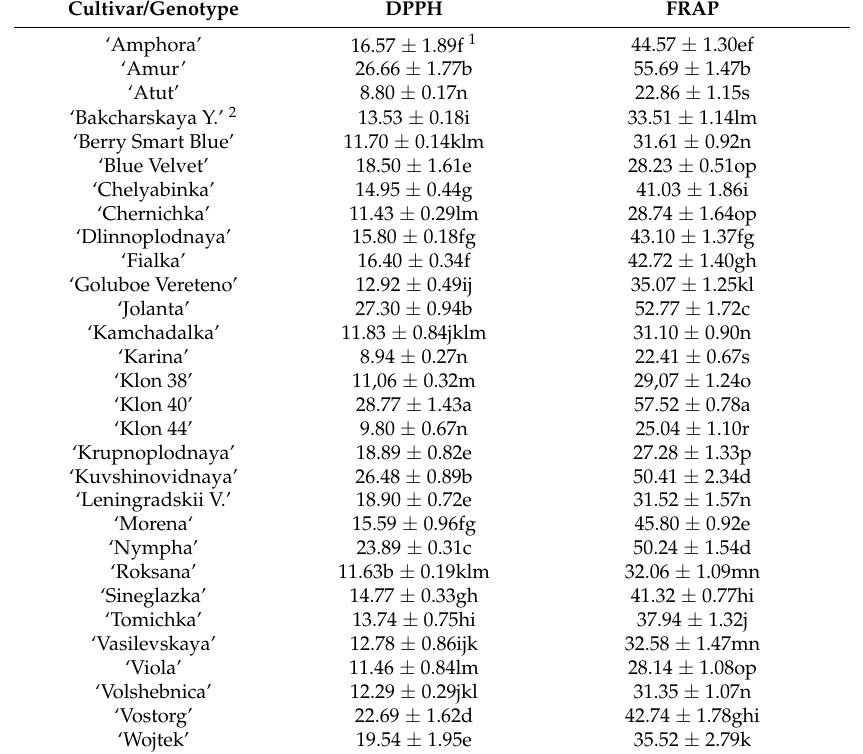
Table 7. Antioxidant activity ( µ mol TE/g fw) of different blue honeysuckle cultivars and